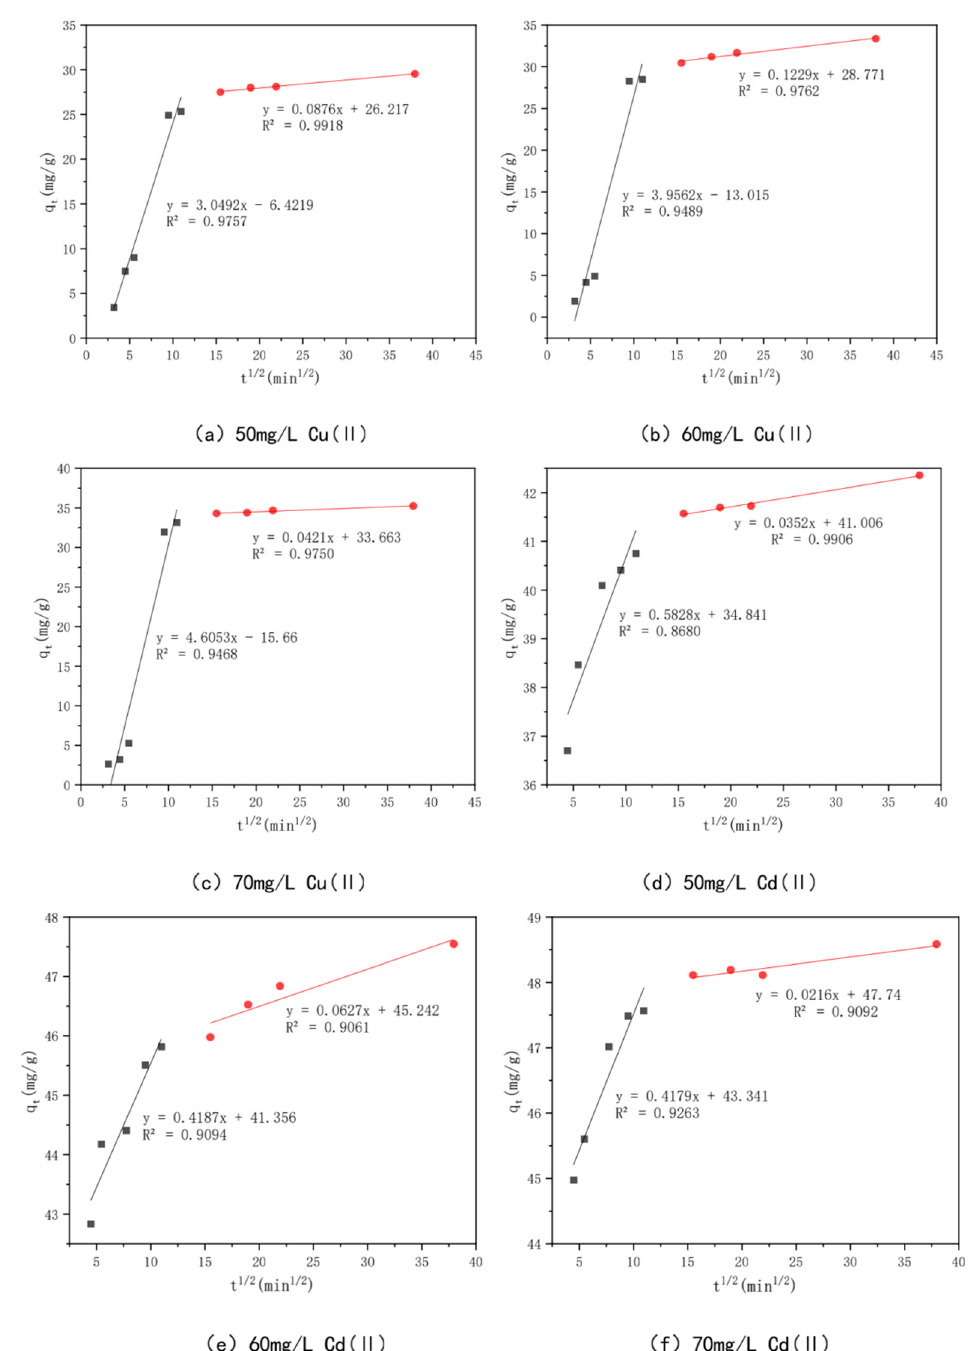
Figure 13. Intraparticle diffusion models of different concentrations of Cu(II)/Cd(II).